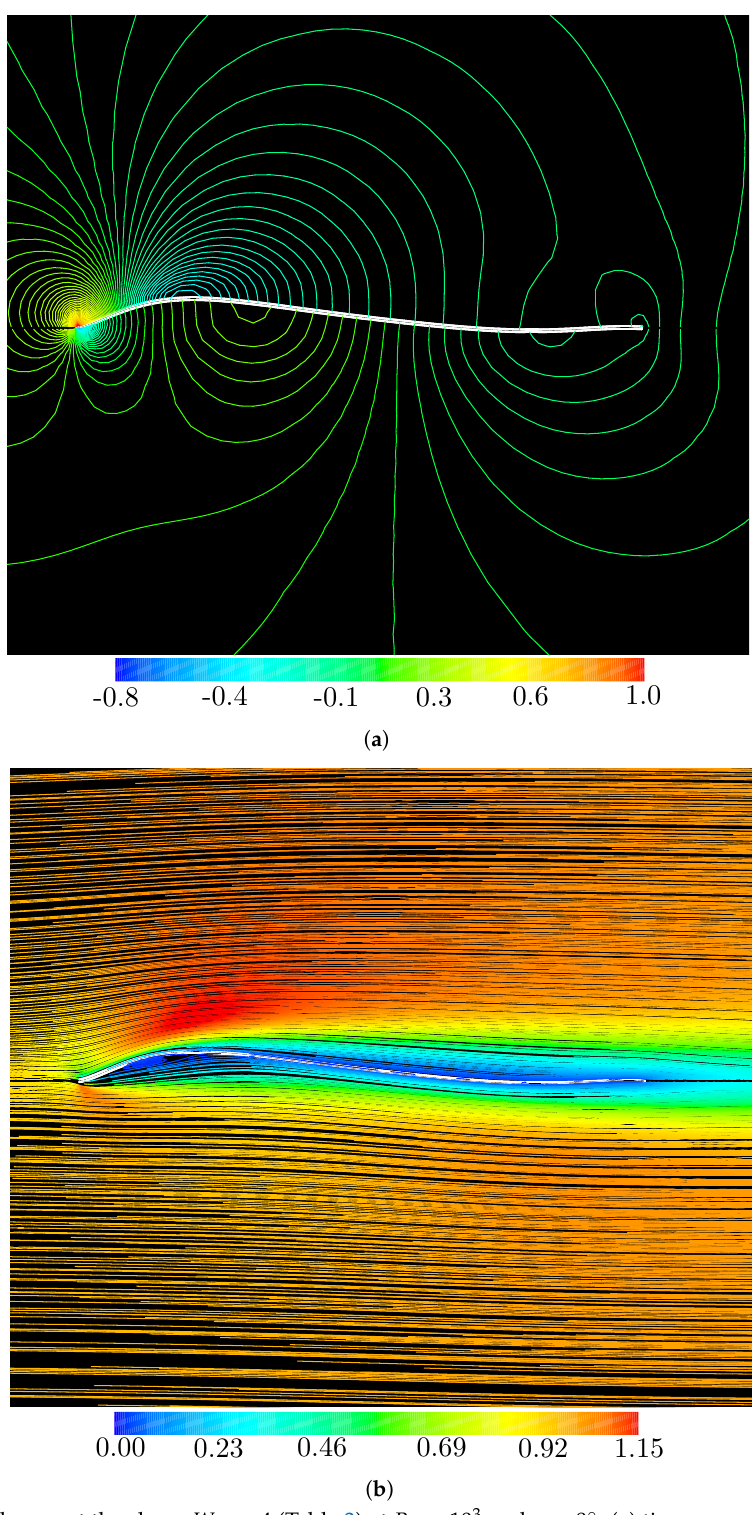
Figure 14. Flow past the shape Wavy _4 (Table 3) at Re = 10 3 and α = 0 ◦ : ( a ) time-averaged pressure isolines; and ( b ) time-averaged